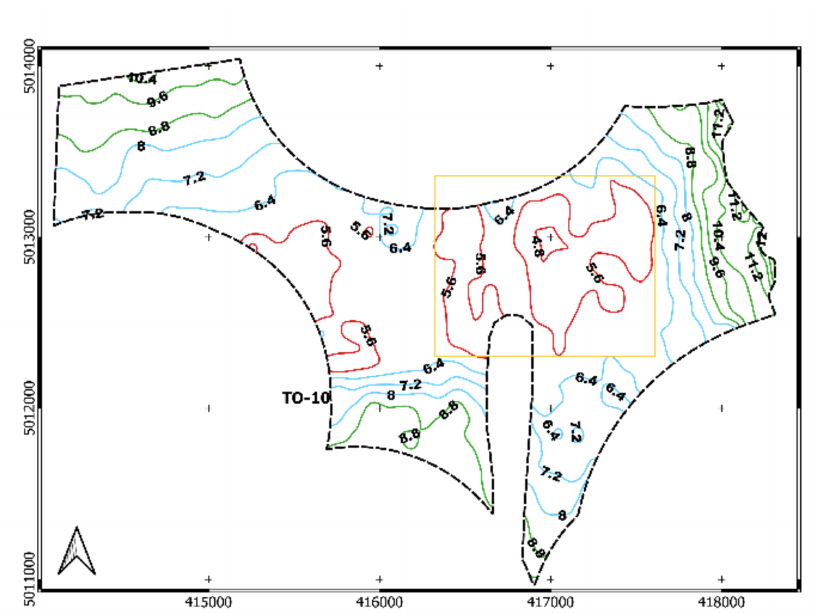
Figure 11. An alternative visualization of the groundwater level (m from the ground) in the TO-10 site. A simplified colour strategy permits to immediately locate zones where groundwater average level is lower than 6 m (red lines), between 6 and 8 m (blue lines) and over 8 m (green lines). Particular meaning has the yellow squared area, introducing a technical limitation/exclusion issue exactly where the EC12 criterion is weaker (compare next section). Reference system is WGS84 UTM